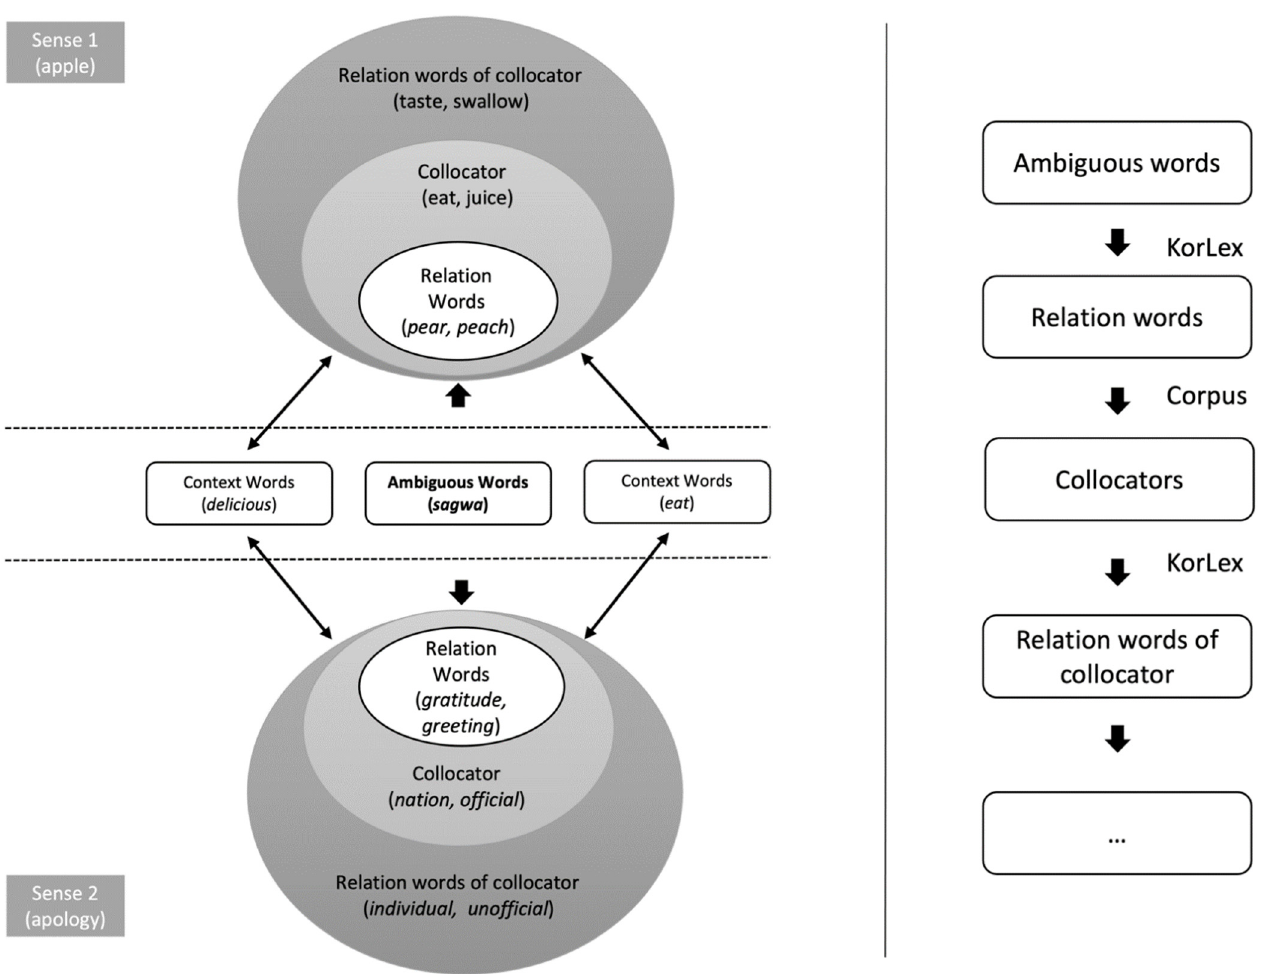
Figure 5. Relationship analysis between words using coordinate terms of semantically related words of the ambiguous word.